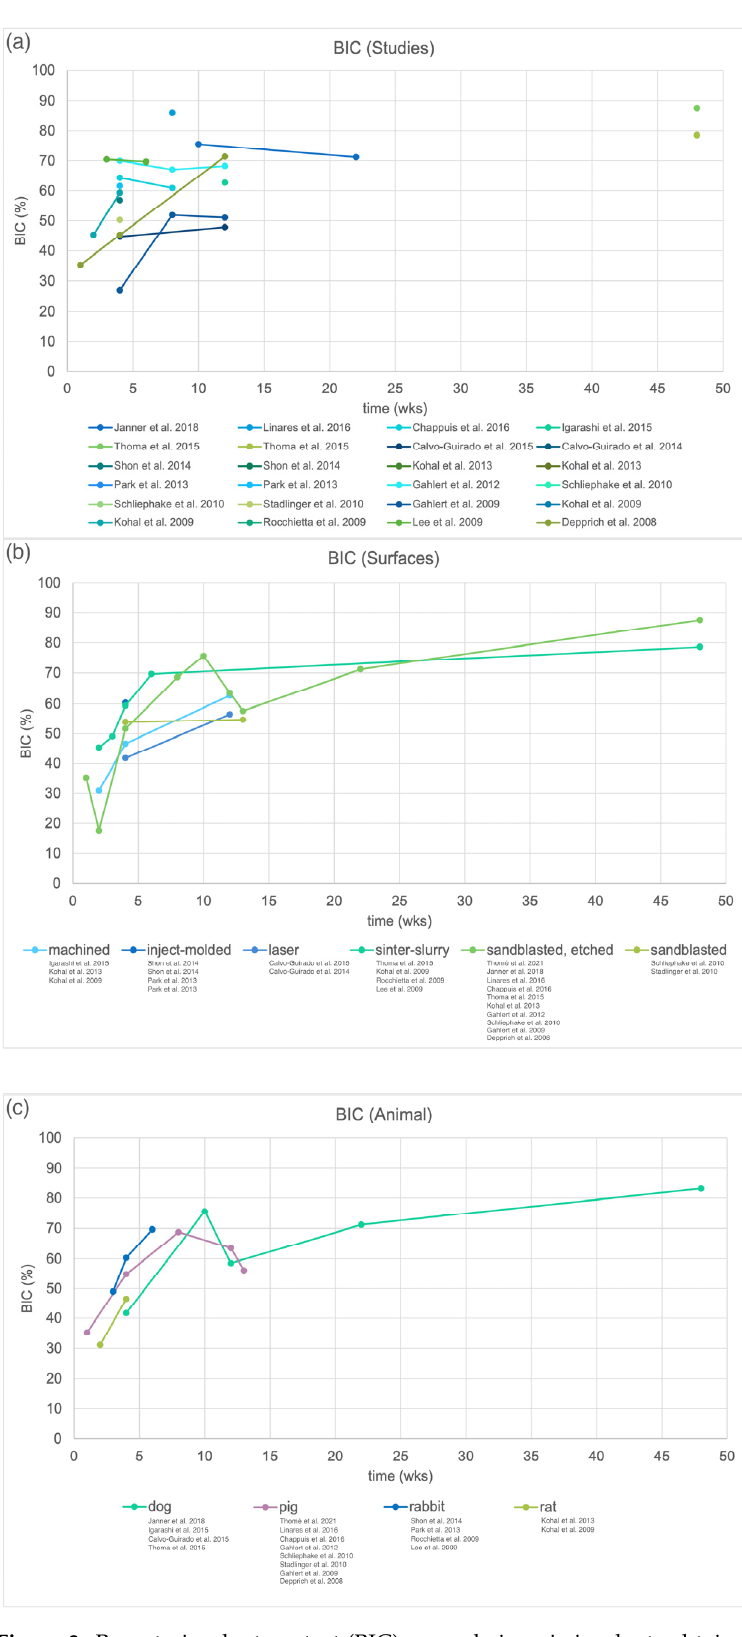
Figure 3. Bone-to-implant contact (BIC) around zirconia implants obtained in preclinical studies. ( a ) BIC of all included studies, ( b ) BIC pooled by surface treatment of zirconia implants and ( c ) BIC pooled by animal model.